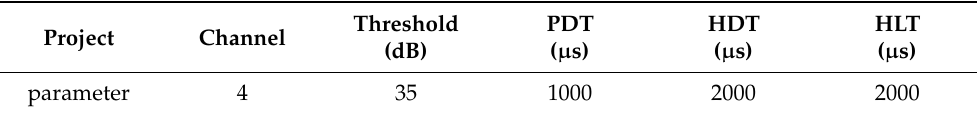
Table 3. Parameter setting of the AE monitoring system.